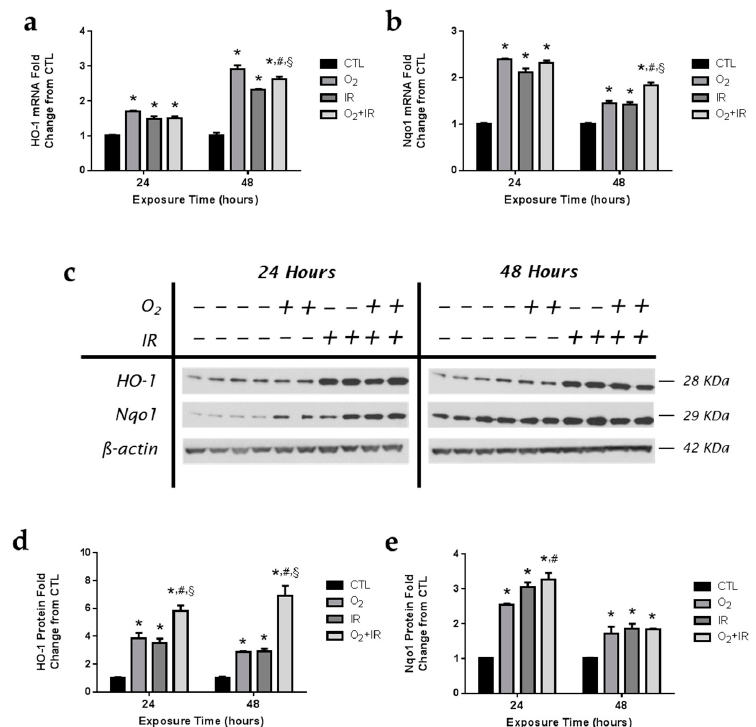
Figure 9. Exposure to hyperoxia, radiation, and double-hit combination challenge induces expression of antioxidant enzymes. Non-tumorigenic murine alveolar type II epithelial cells (C10) were evaluated after 1 and 2 cycles of hyperoxia and radiation exposure and evaluated by qPCR analysis of ( a ) HO-1 and ( b ) Nqo1 mRNA levels and by ( c ) western blotting for HO-1 and Nqo1. Levels of target gene mRNA were normalized to 18S ribosomal RNA and values are expressed as the mean fold change from CTL. Densitometric analysis of band intensity for ( d ) HO-1 and ( e ) Nqo1 was normalized to β -actin and values are expressed as fold change from CTL. Data are presented as mean ± SEM. * p < 0.05 for each exposure condition as it compares with the unexposed control (CTL) in the same respective time-group; # p < 0.05 for significant differences between O 2 -alone compared to O 2 + IR; § p < 0.05 for significant differences between IR-alone compared to O 2 + IR.